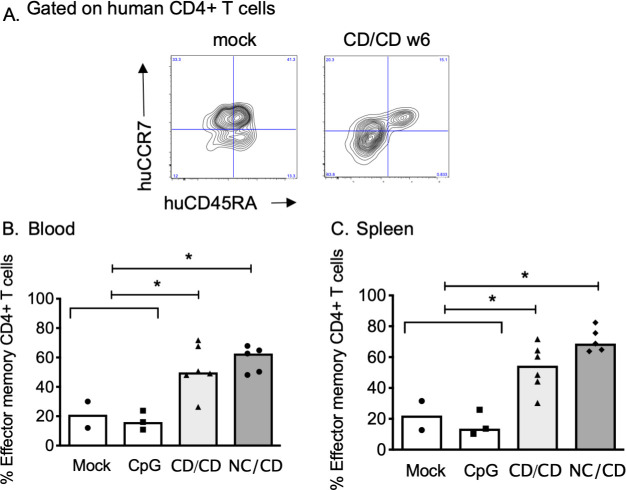
Vaccination elicits expansion of human memory T cells.(A) Flow cytometry of splenocytes from hu-mice injected three times with PBS (mock) or the anti-CD40.Env gp140 vaccine (CD/CD) one week after the last injection (w6). The human CD4+ T cells (see their gating strategy in S1 Fig) were represented in a huCCR7 versus huCD45RA dot blot to identify the human effector memory CD4+ T cells (CCR7- CD45RA-). (B-C) Frequency of human effector memory CD4+ T cells in the blood (B) and spleens (C) of hu-mice. Individual values are presented, along with the median. Mann-Whitney U-tests were used for comparisons between immunized and non-immunized hu-mice. *p < 0.05.